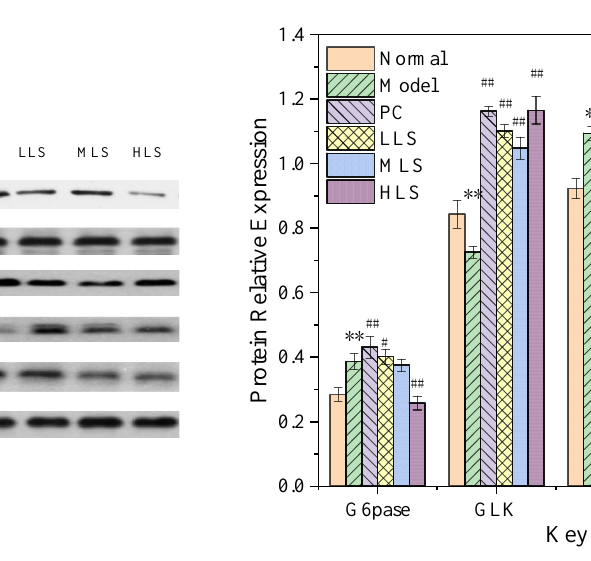
Figure 1. Effect of oral sericin on the expression of key hepatic glucose metabolism proteins in T2D rats. Normal: normal group; Model: diabetic model group; PC: 0.5% melbin; LLS, MLS, and HLS: 1%, 2.5%, and 5% LS, respectively. n = 3, ** p < 0.01 versus normal group. # p < 0.05, ## p < 0.01 versus model group.